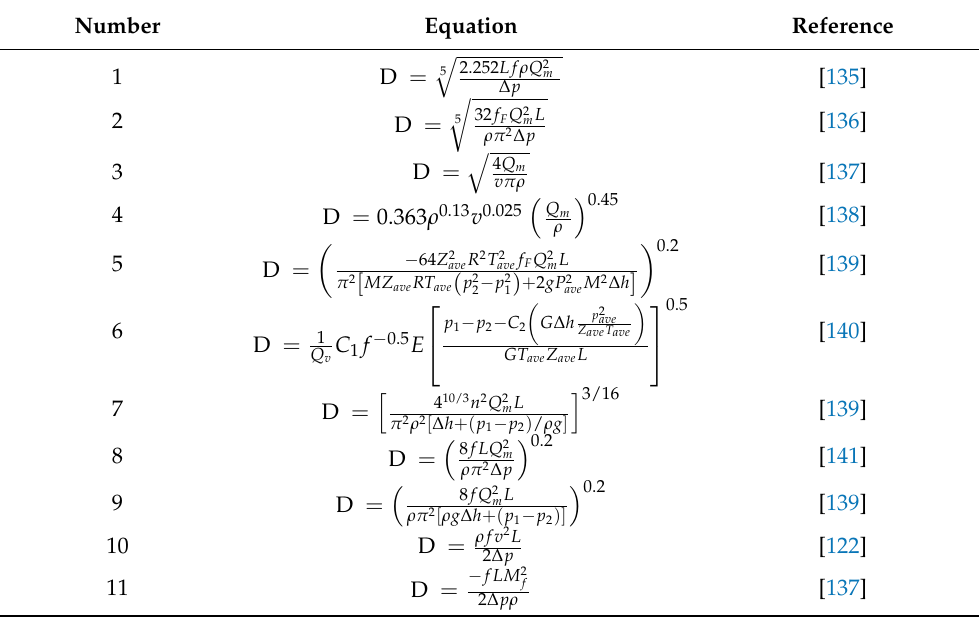
Table 2. Pipe diameter